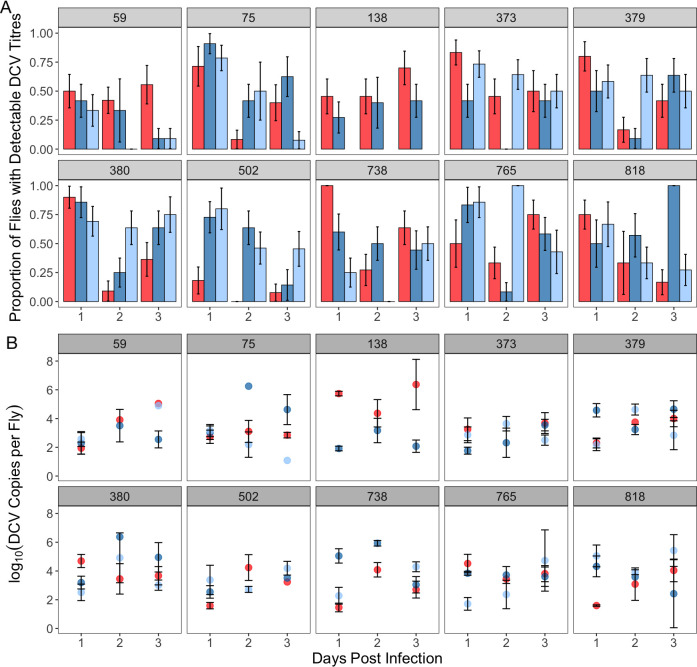
Mean±SE (a) proportion of flies with detectable loads of DCV and the (b) viral titre of flies with non-zero DCV loads, over the first 3 days of infection. Across both panels, numbers in each pane denote the genetic background from the DGRP, while the colour of bars, points and lines represent sex and mating status. Males are shown in red, mated females in blue, and virgin females in pale blue.